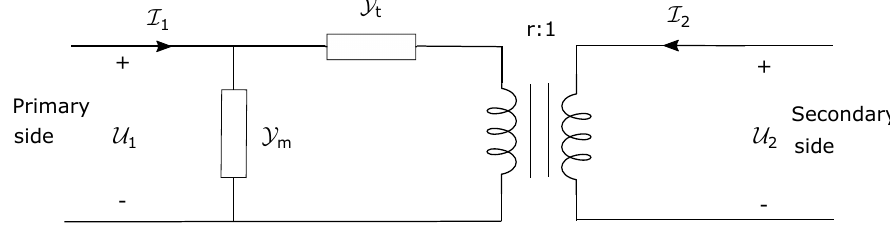
Figure 3. Equivalent circuit for a single-phase